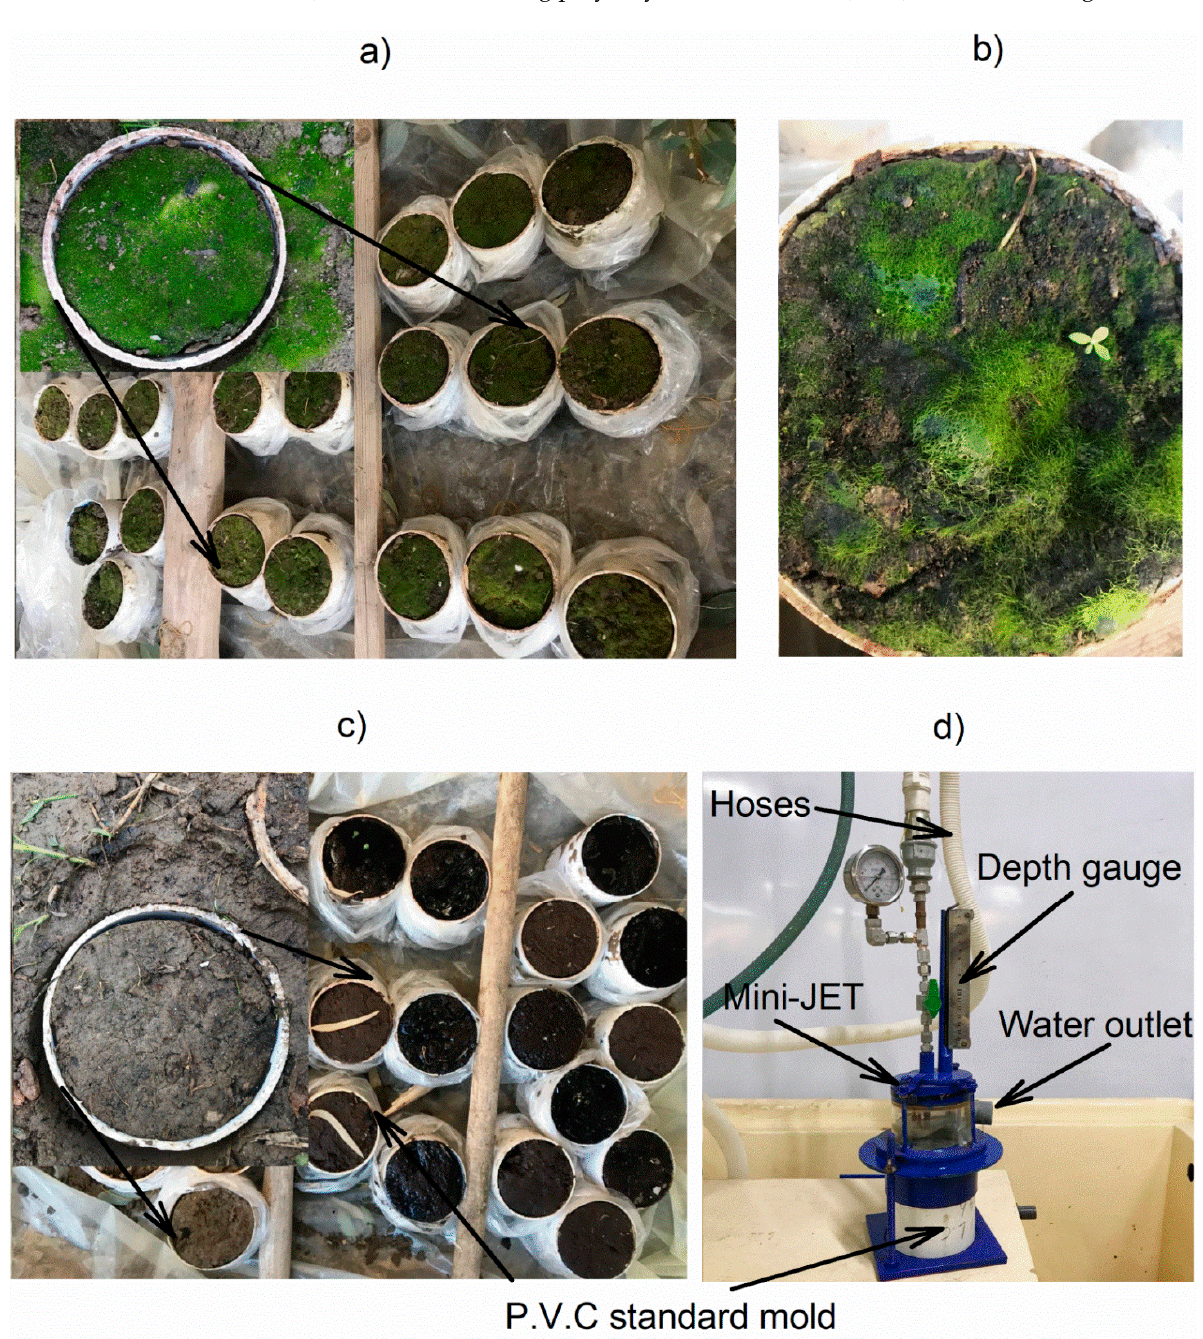
Figure 2. ( a ) Undisturbed crusted soil samples, ( b ) crusted soil samples with humic acids, ( c ) undisturbed uncrusted soil samples with and without humic acids, and ( d ) mini-JET device setup at the Hydraulic Lab.